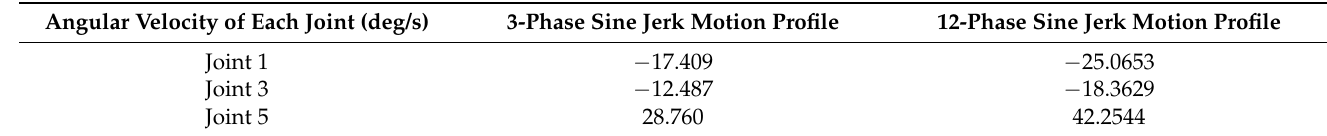
Table 6. Comparison of average peak angular velocity of joints’ 3-phase and 12-phase sine jerk motion profile in the